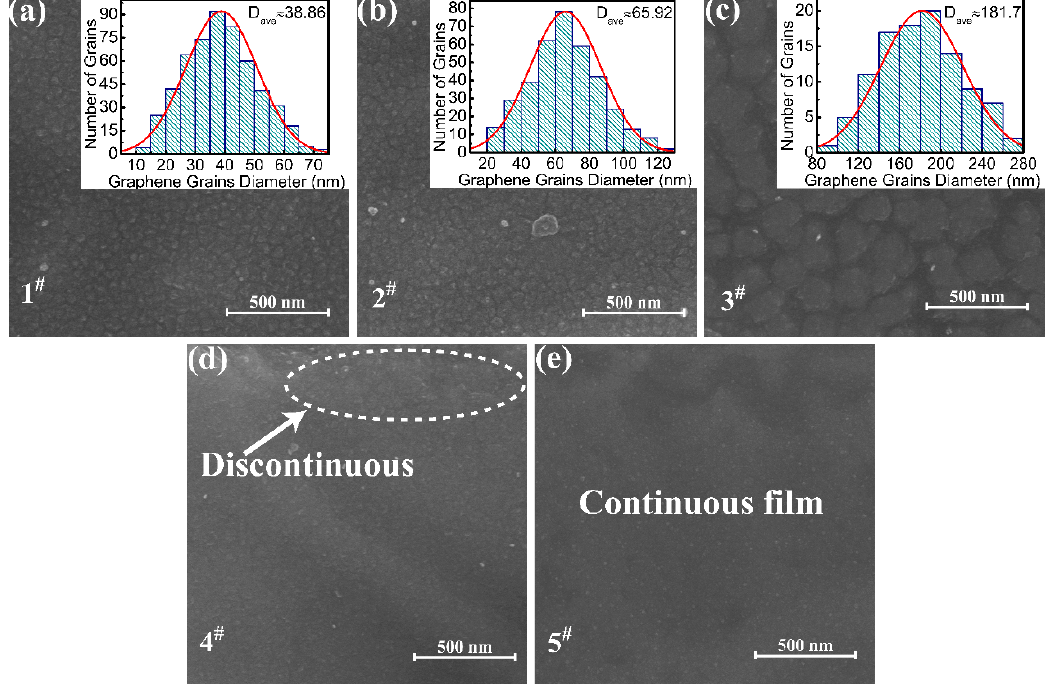
Figure 2. Scanning electron microscopy (SEM) image of ( a ) sample 1 # , ( b ) sample 2 # , ( c ) sample 3 # , ( d ) sample 4 # , and ( e ) sample 5 # . The inset in ( a – c ) show the corresponding grain size distribution. The white dotted ellipse in ( d ) shows the discontinuous part.